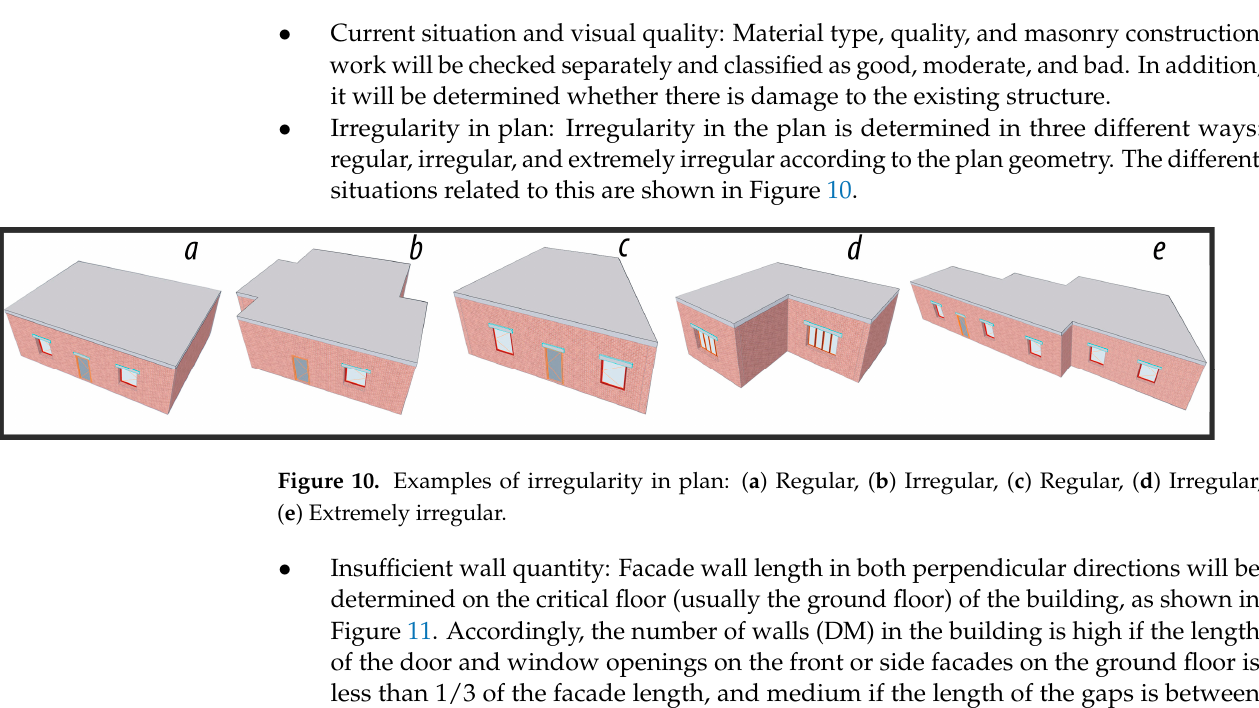
Figure 9. Floor levels in adjacent buildings: ( a ) Same, ( b )Same (Limit condition), ( c ) Different.